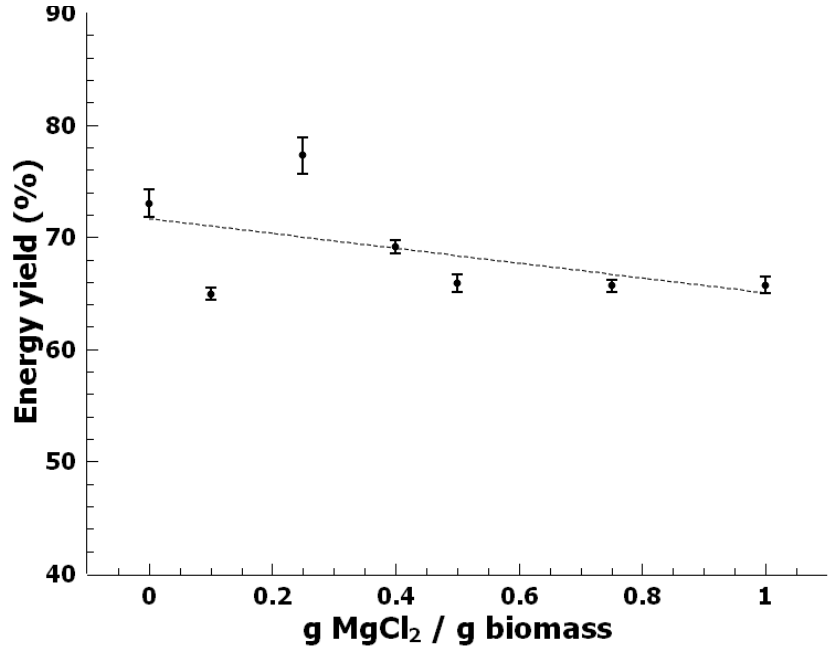
Figure 4. Effect of magnesium chloride on energy yield. Figure 4. E ff ect of magnesium chloride on energy